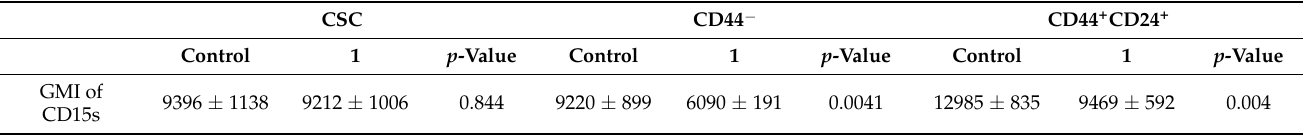
Table 5. Expression of CD15s in CSC, CD44 − and CD44 + CD24 + subpopulations after treatment with compound